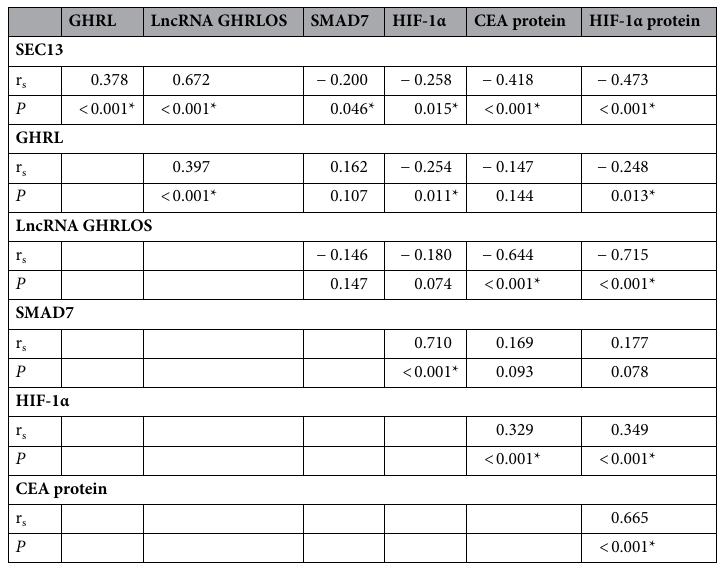
Table 3. Correlation between SEC13, GHRL, lncRNA GHRLOS, SMAD7, HIF-1α genes expression, serum HIF-1α and CEA levels in gastric cancer patients’ group. r s : Spearman coefficient.